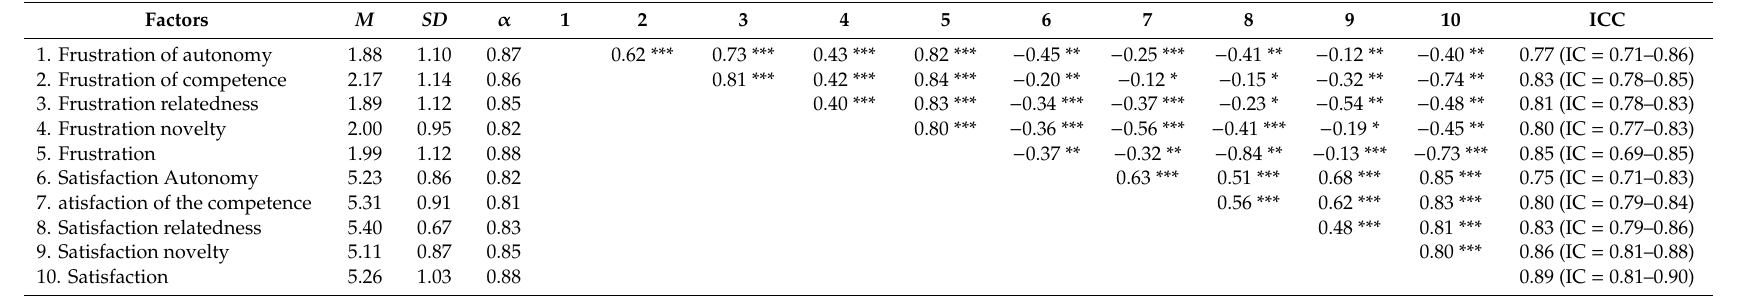
Table 3. Descriptive Statistics and Correlations between all BPNS